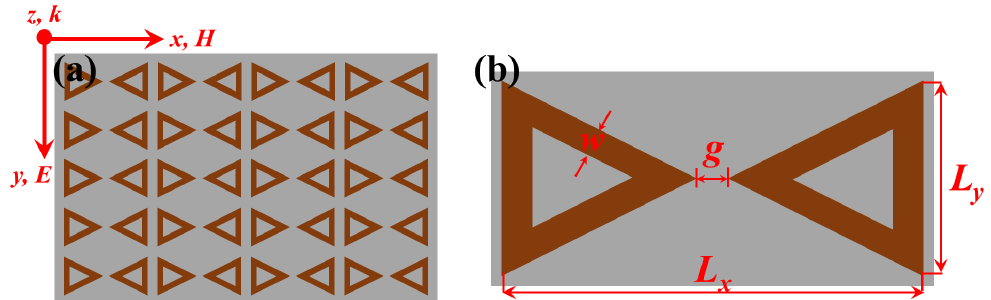
Figure 1. Schematic diagram of hydrogenated BP monolayer-based metasurface on the silicon substrate: ( a ) Periodic structure where the incident THz waves with x -polarization are along the z -direction; ( b ) The unit cell with geometrical parameters where L x varies with L y , g = 2 µ m, and w = 6 µ m. The periodicity is set to L x + w and L y + w for x and y